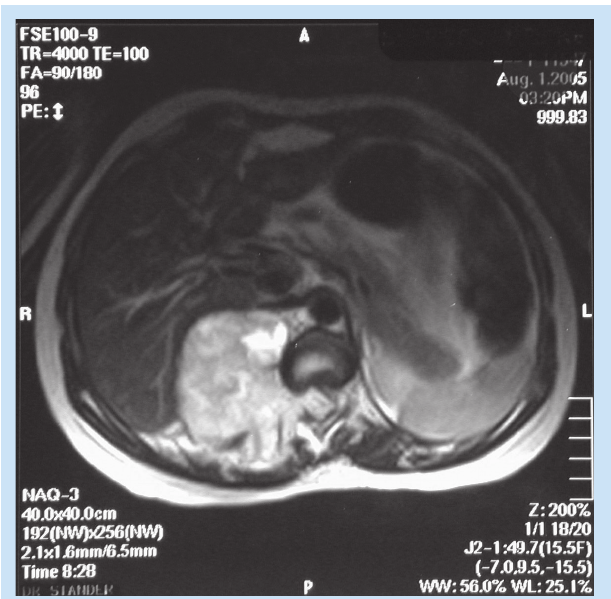
Fig. 4. A T2-weighted image on the same level as Fig. 3 shows a hyperin- tense heterogeneous mass. The invasion of the chest wall and spinal canal with widened intervertebral foramen and displaced spinal cord is clearly seen.